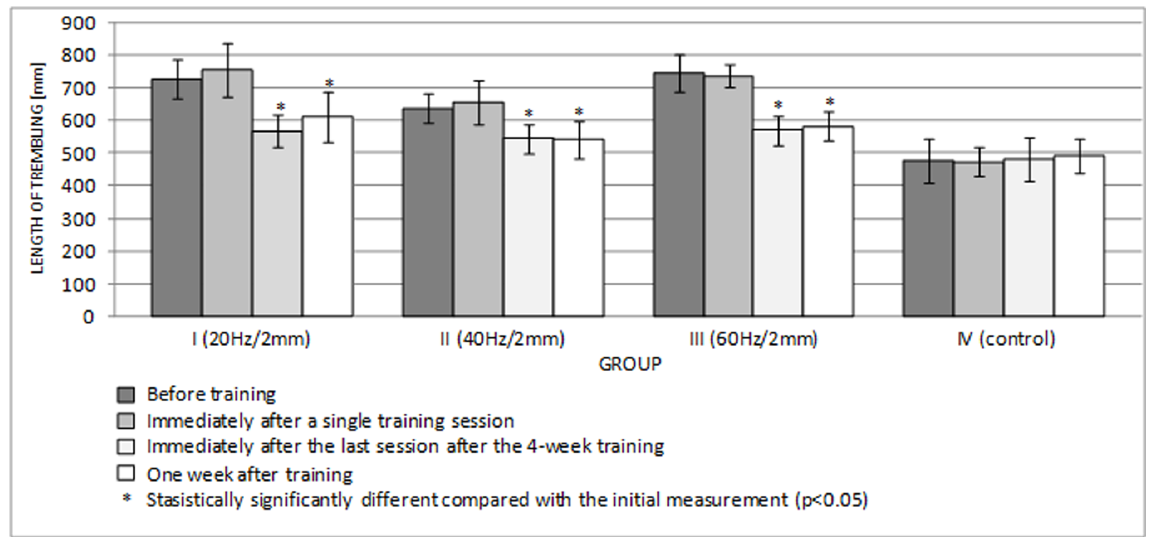
Figure 9. Length of trembling in the ML plane (mean ± standard deviation) (mm) after training.